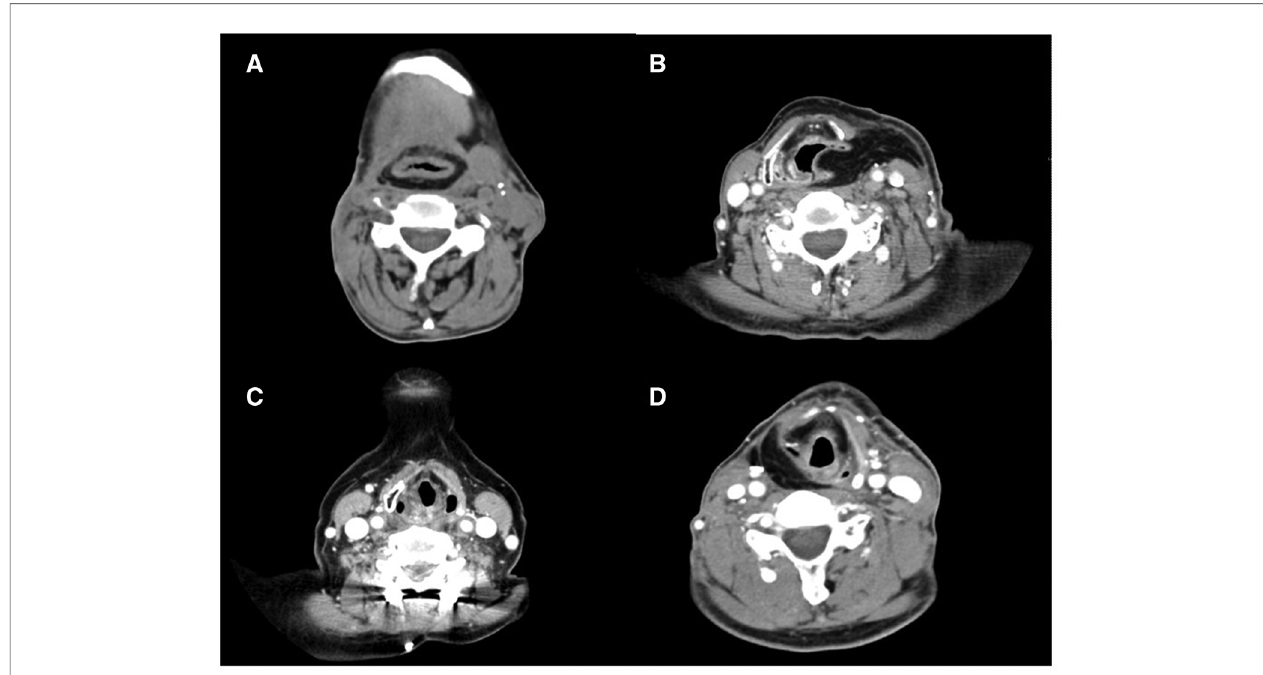
FIGURE 2 | Postoperative neck computed tomography scans of each group classi fi ed by surgical resection extent. ( A ) Patient who underwent total laryngopharyngectomy with anterolateral thigh free fl ap (ALT FF) reconstruction (group 1). ( B ) Patient who underwent left vertical partial laryngectomy (VPL) and left pharyngectomy via lateral pharyngotomy approach with ALT FF reconstruction (group 2). ( C ) Patient who underwent transoral laser excision of the right posterior pharyngeal wall mass (group 3). ( D ) Patient who underwent right partial pharyngectomy via lateral pharyngotomy approach with ALT FF reconstruction (group